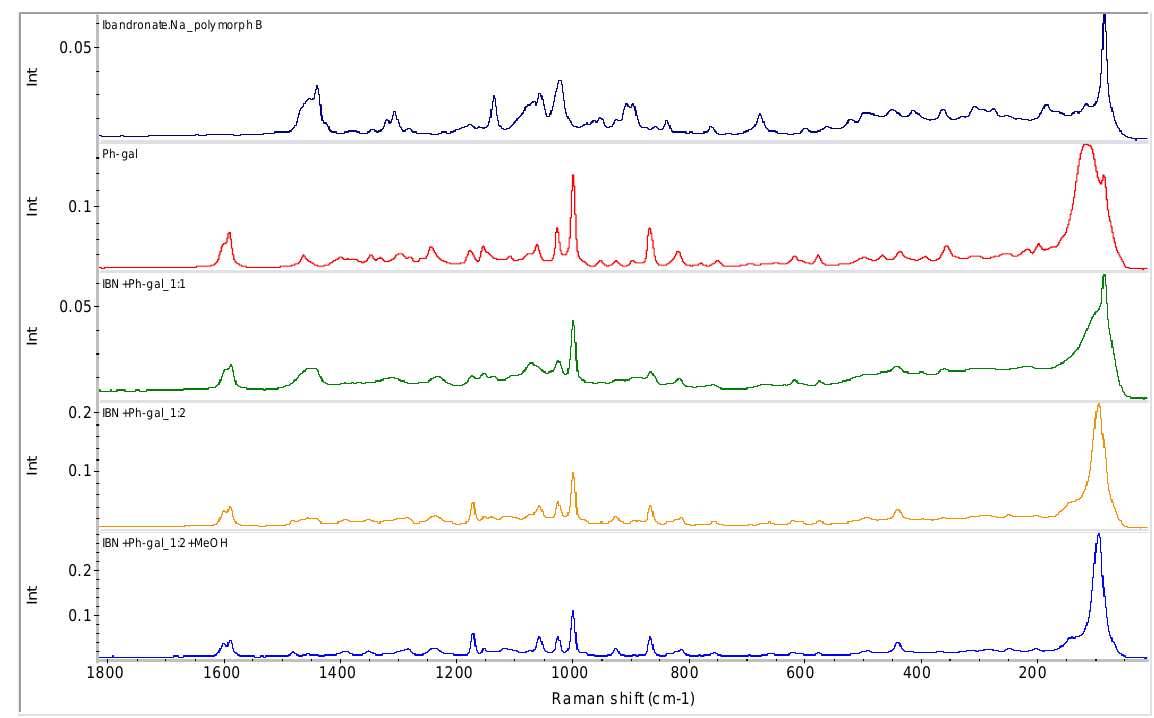
Figure 11. FT-Raman spectra of starting ibandronate monosodium salt form B, phenyl- β - D -galactopyranoside (Ph-gal) and spectra of their selected potential co-crystals (samples 1 , 2 and 6 ).